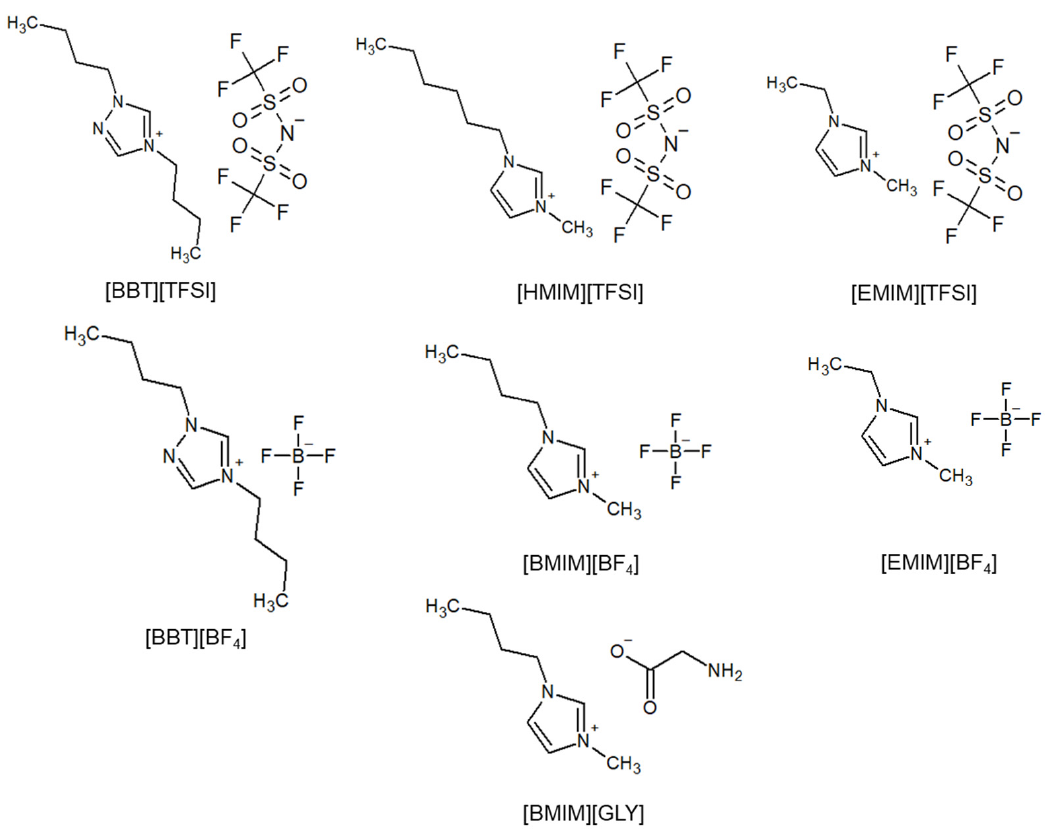
Figure 1. Molecular structures of ionic liquids used in this work.